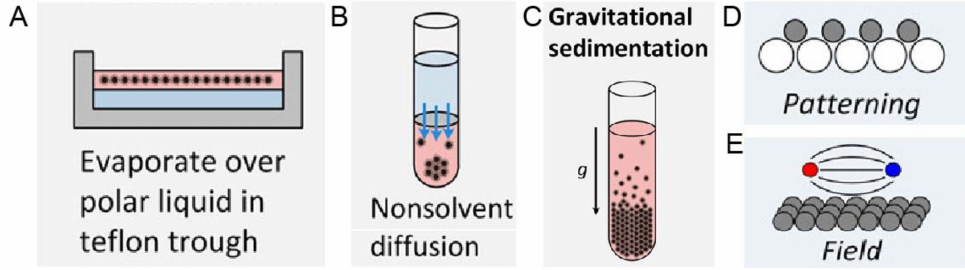
Figure 5. Schematic experimental approaches to prepare superstructures from nanoparticles, in- cluding ( A ) Solvent evaporation based methods, such as evaporation over a polar liquid in a Teflon trough; ( B ) Solvent destabilization-based methods, such as nonsolvent diffusion; ( C ) Gravitational sedimentation, which is a less common method due to insignificant gravitational forces for intrinsi- cally small sizes of nanoparticles; ( D ) Pattering, where the template is normally used to guide the ordering and ( E ) Ordering in an external field, especially magnetic and electric fields. Reproduced with permission from [55], Copyright the American Chemical Society,